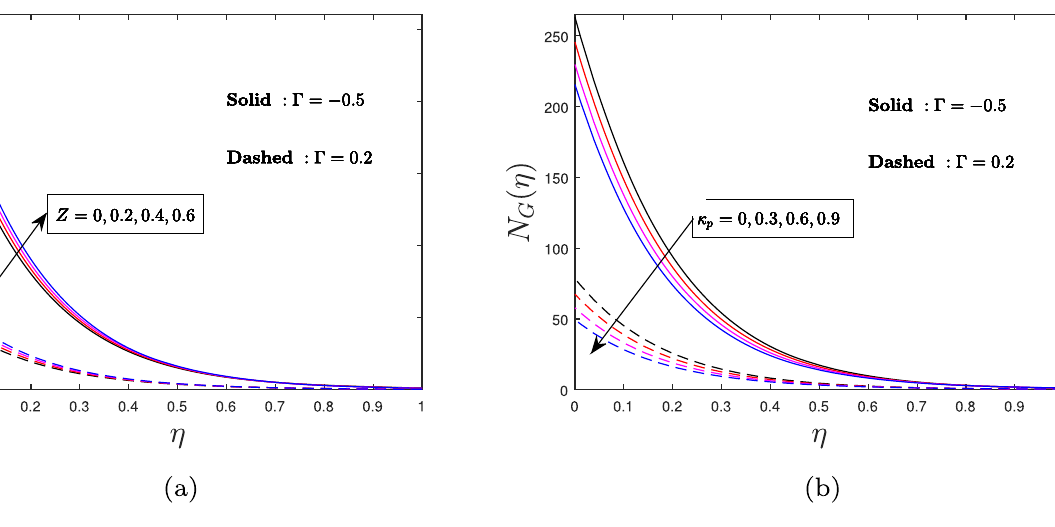
Figure 15: Entropy generation pro fi les against ( a ) Z and ( b ) k p